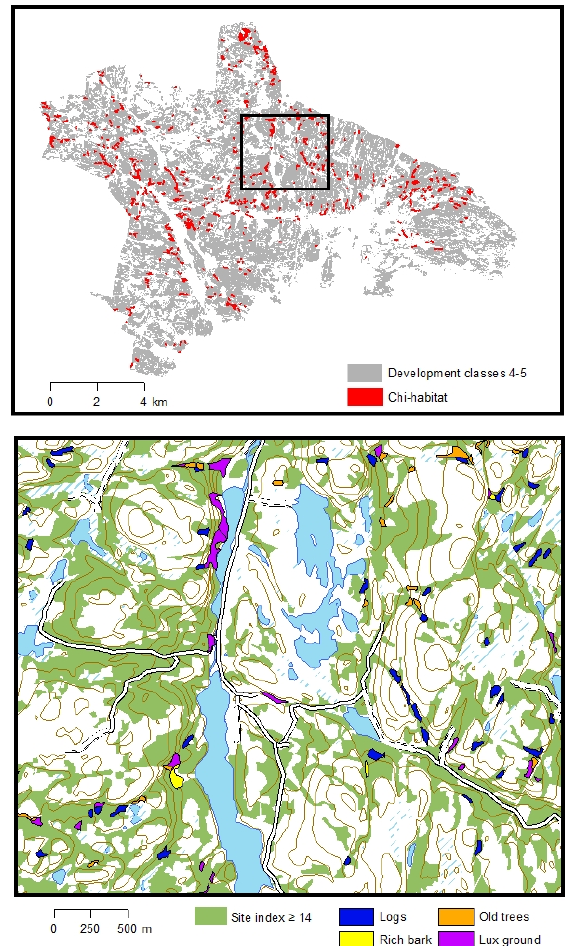
Figure 2. An example (from Søgne municipality) of a typical distribution of mapped CHI habitats within a landscape.